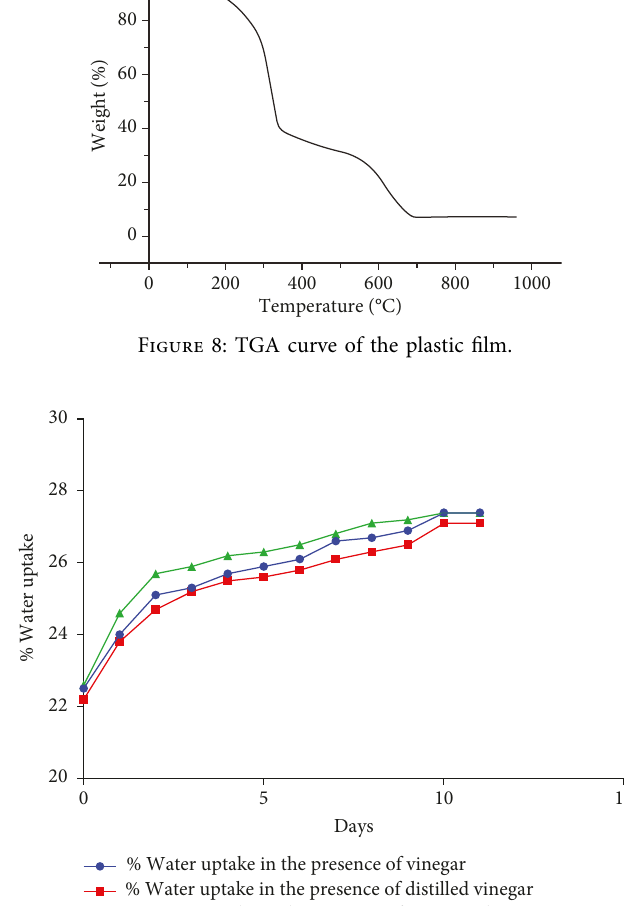
Figure 9: Water uptake for films in the presence of vinegar, distilled vinegar, and acetic acid.